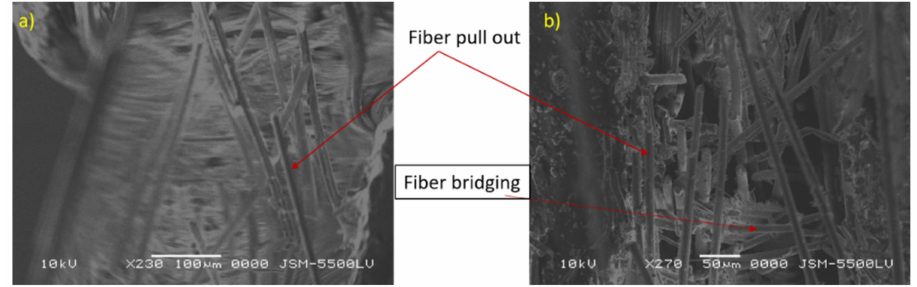
Figure 11. ( a , b ) SEM examination of fracture surface in compact tension specimen. The variation of the tensile strength values of each of the four specimens ranged from 30 MPa to 14 MPa for specimen number 1 and 4 respectively, this variation was due to an error in the specimen preparation, machine stiffness, misalignment error, the maximum variation percent were nearly 50% while minimum percent was 30%, this is because of